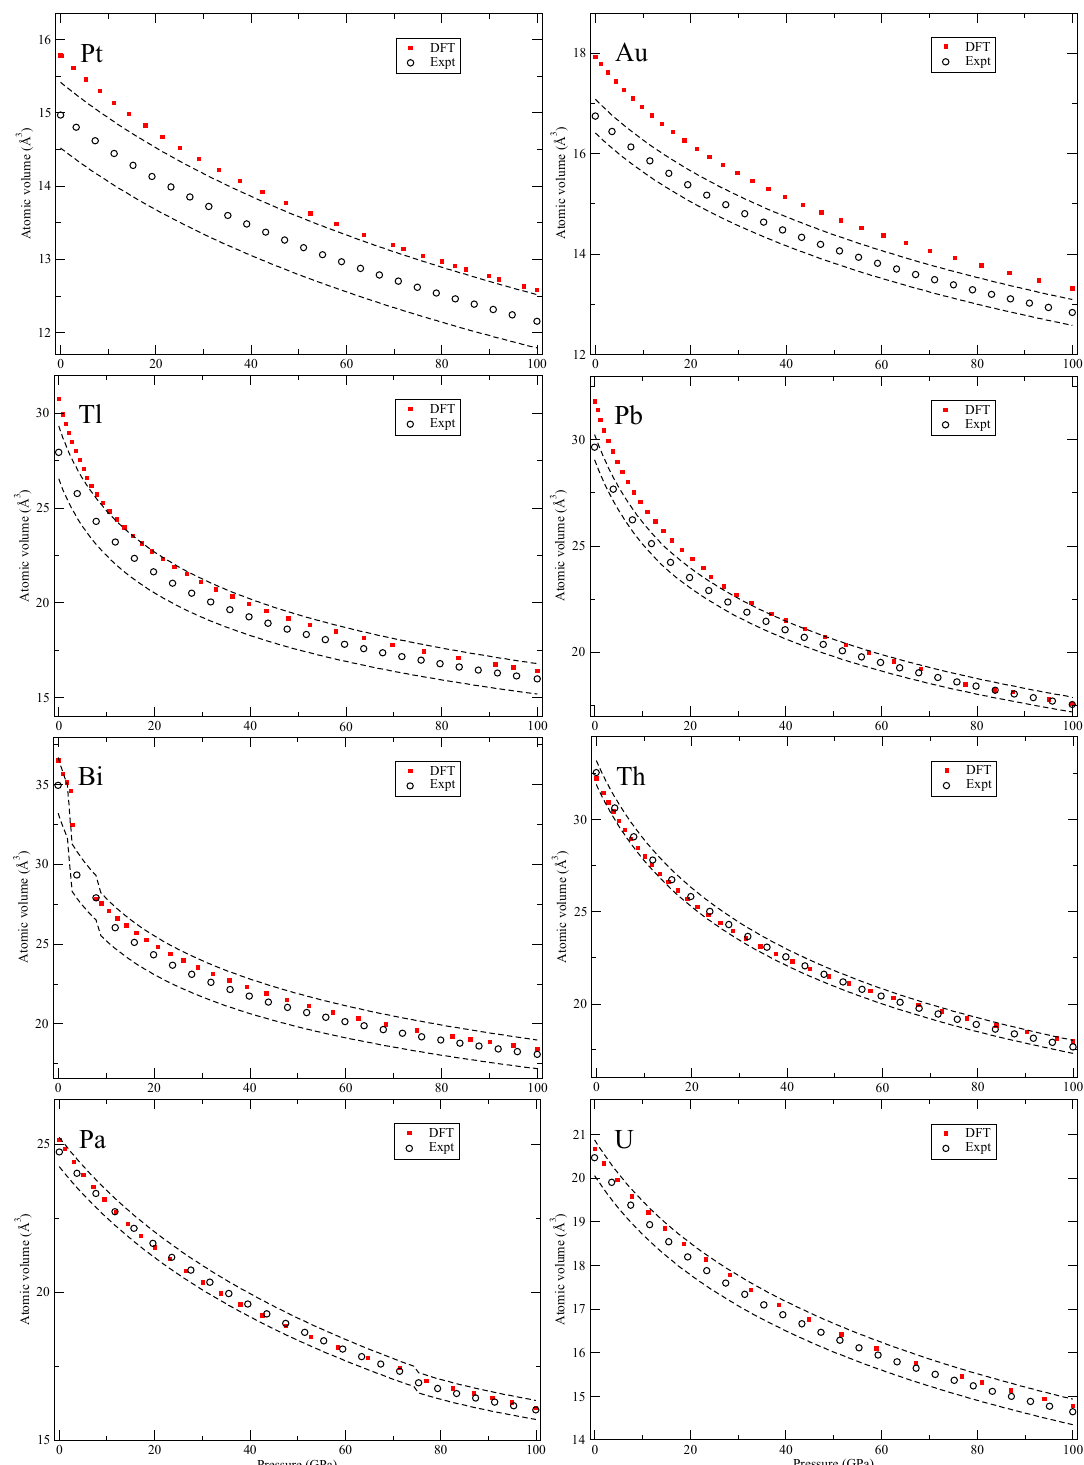
Figure 9. Experimental and DFT EOS for Pt, Au, Tl, Pb, Bi, Th, Pa and U.